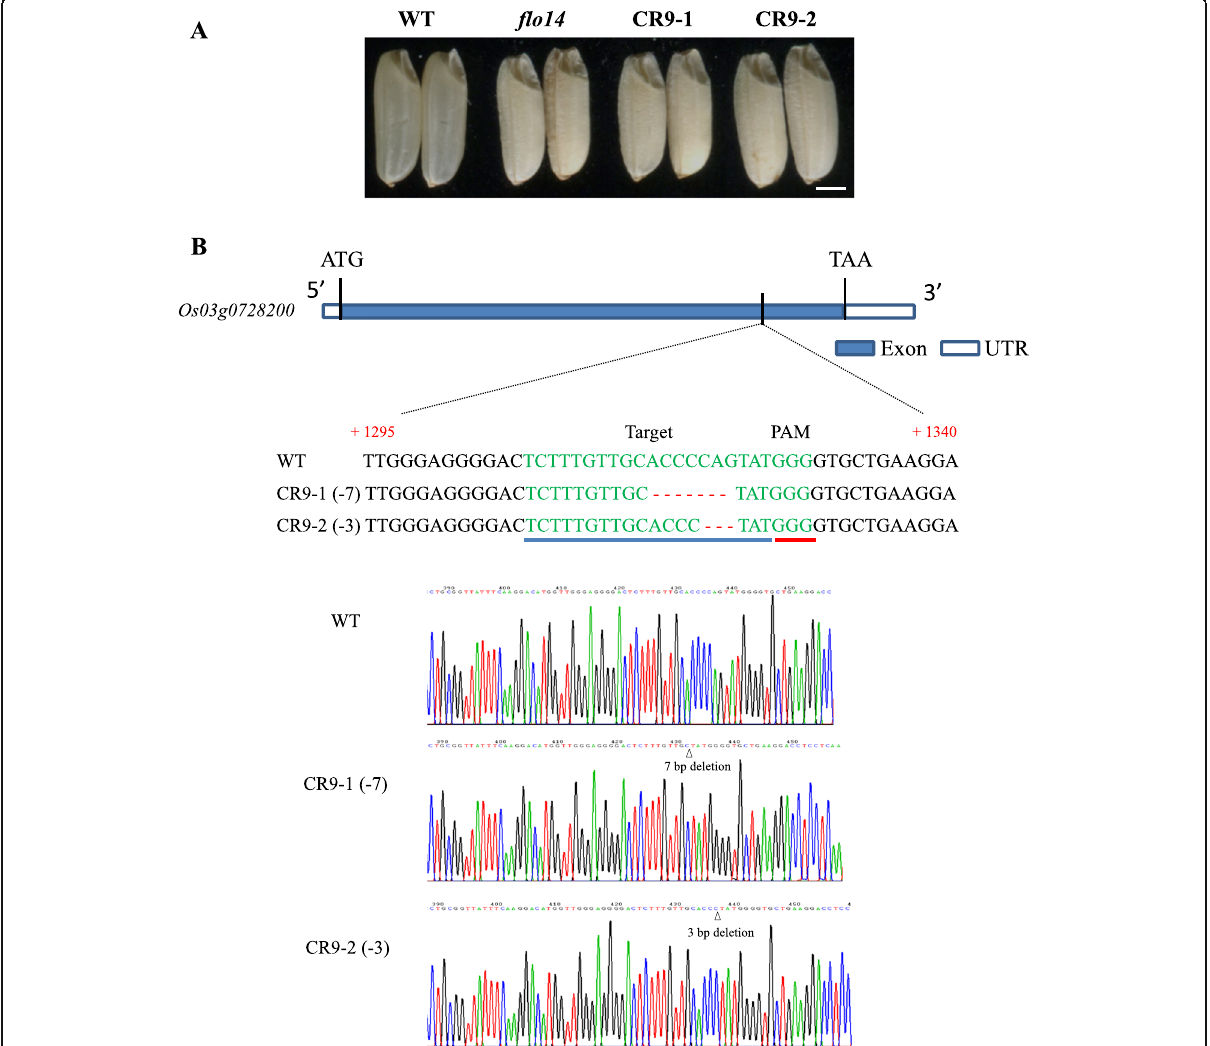
Fig. 4 Knockout of the OsNPPR3 gene by CRISPR system. a Seeds of the wild type (WT), flo14 mutant ( flo14 ), and two independent CRISPR/Cas9 T 1 transgenic lines, which were named CR9 – 1 and CR9 – 2. b Verification of the knockout lines by PCR-based sequencing. The representative transgenic lines were generated from Oryza sativa L. japonica variety Dianjingyou1 genetic background. ATG and TAG indicate the start and stop codons, respectively. UTR means untranslated region. Arabic number indicates the base position from the start codon. The target sequences designed for knocking out the Os03g0728200 by CRISPR/Cas9 system and the protospacer-adjacent motif (PAM) are underlined in blue and red, respectively. The missing bases are marked with red dotted lines. The chromatograms of the wild type and two knockout lines (CR9 – 1 and CR9 – 2) are shown. Triangle means the site of base deletion in the knockout line. Scale bars:1 mm in ( a